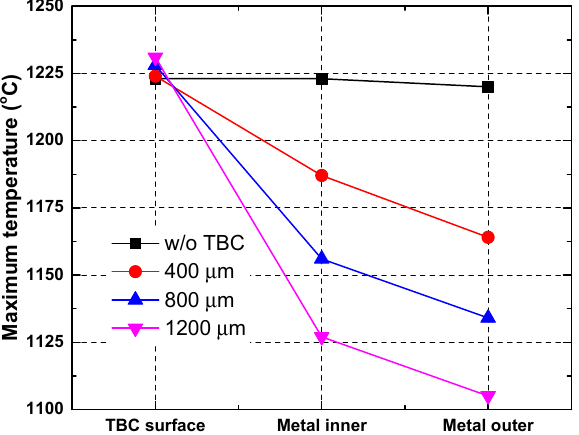
Figure 15. Maximum wall temperature of all surfaces based on the TBC thickness. Figure 16 shows that the 𝑑𝑇 between the TBC surface and inner metal surface was increased linearly; the correlation is expressed in Equation (8). The 𝑑𝑇 between the inner metal and outer metal surface was around 4%, and thus, had not changed remarkably